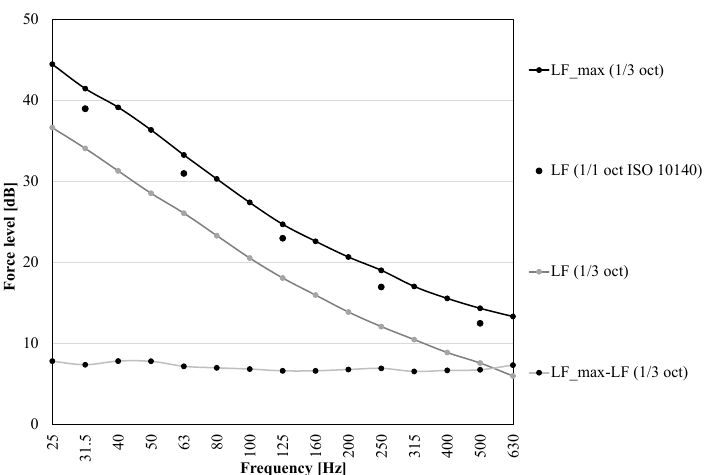
Figure 6. Comparison of L F _max (1/3 oct), L F (1/1 octave), L F (1/3 octave), L F _max ‐ L F (1/3 oct).